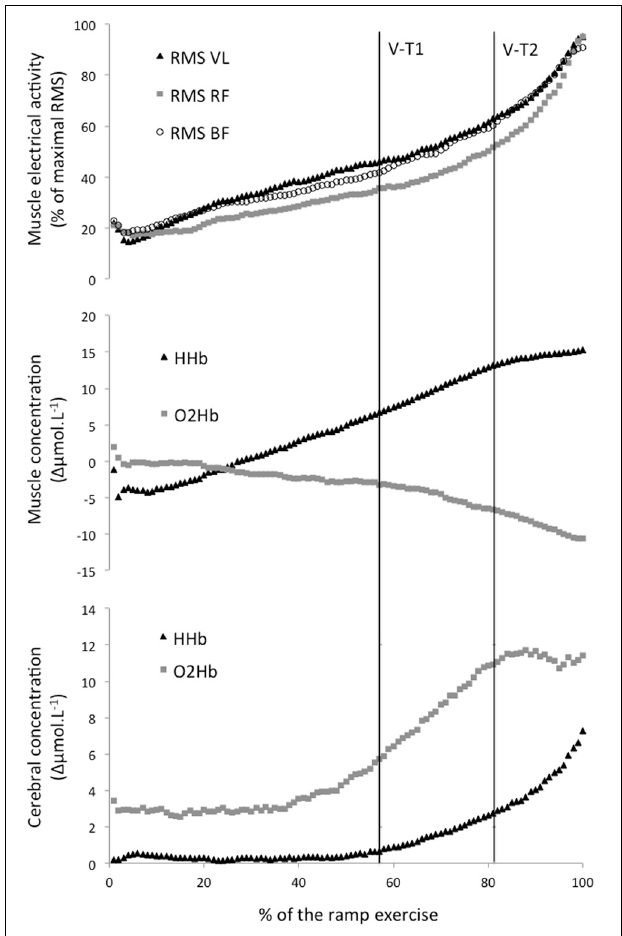
FIGURE 1 | Average electromyographic (top graph) and Near Infrared Spectroscopy (middle graph: muscle, bottom graph: cerebral) parameters during an incremental ramp exercise. V-T1 and V-T2, first and second ventilatory threshold. RMS, root mean square; VL, vastus lateralis ; RF, rectus femoris ; BF, biceps femoris ; HHb, deoxyhemoglobin; O 2 Hb. oxyhemoglobin.